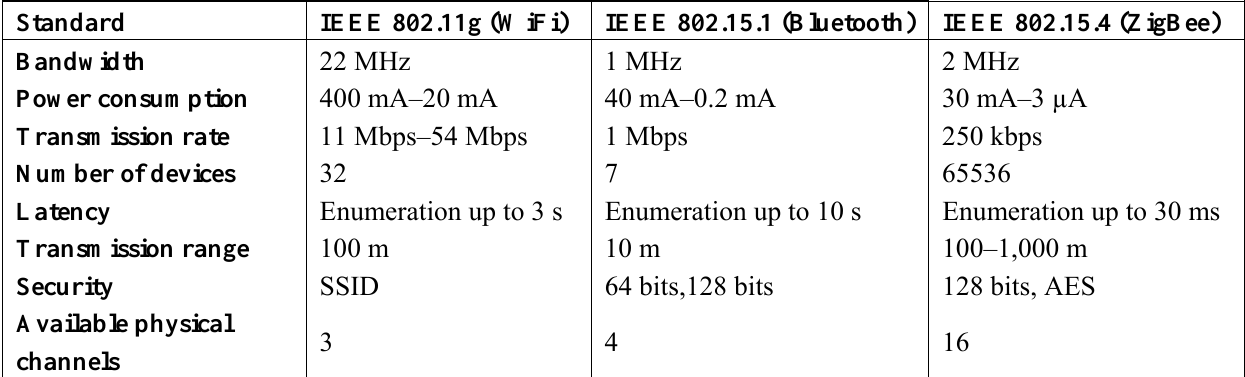
Table 1. Comparative between WiFi, Bluetooth and ZigBee